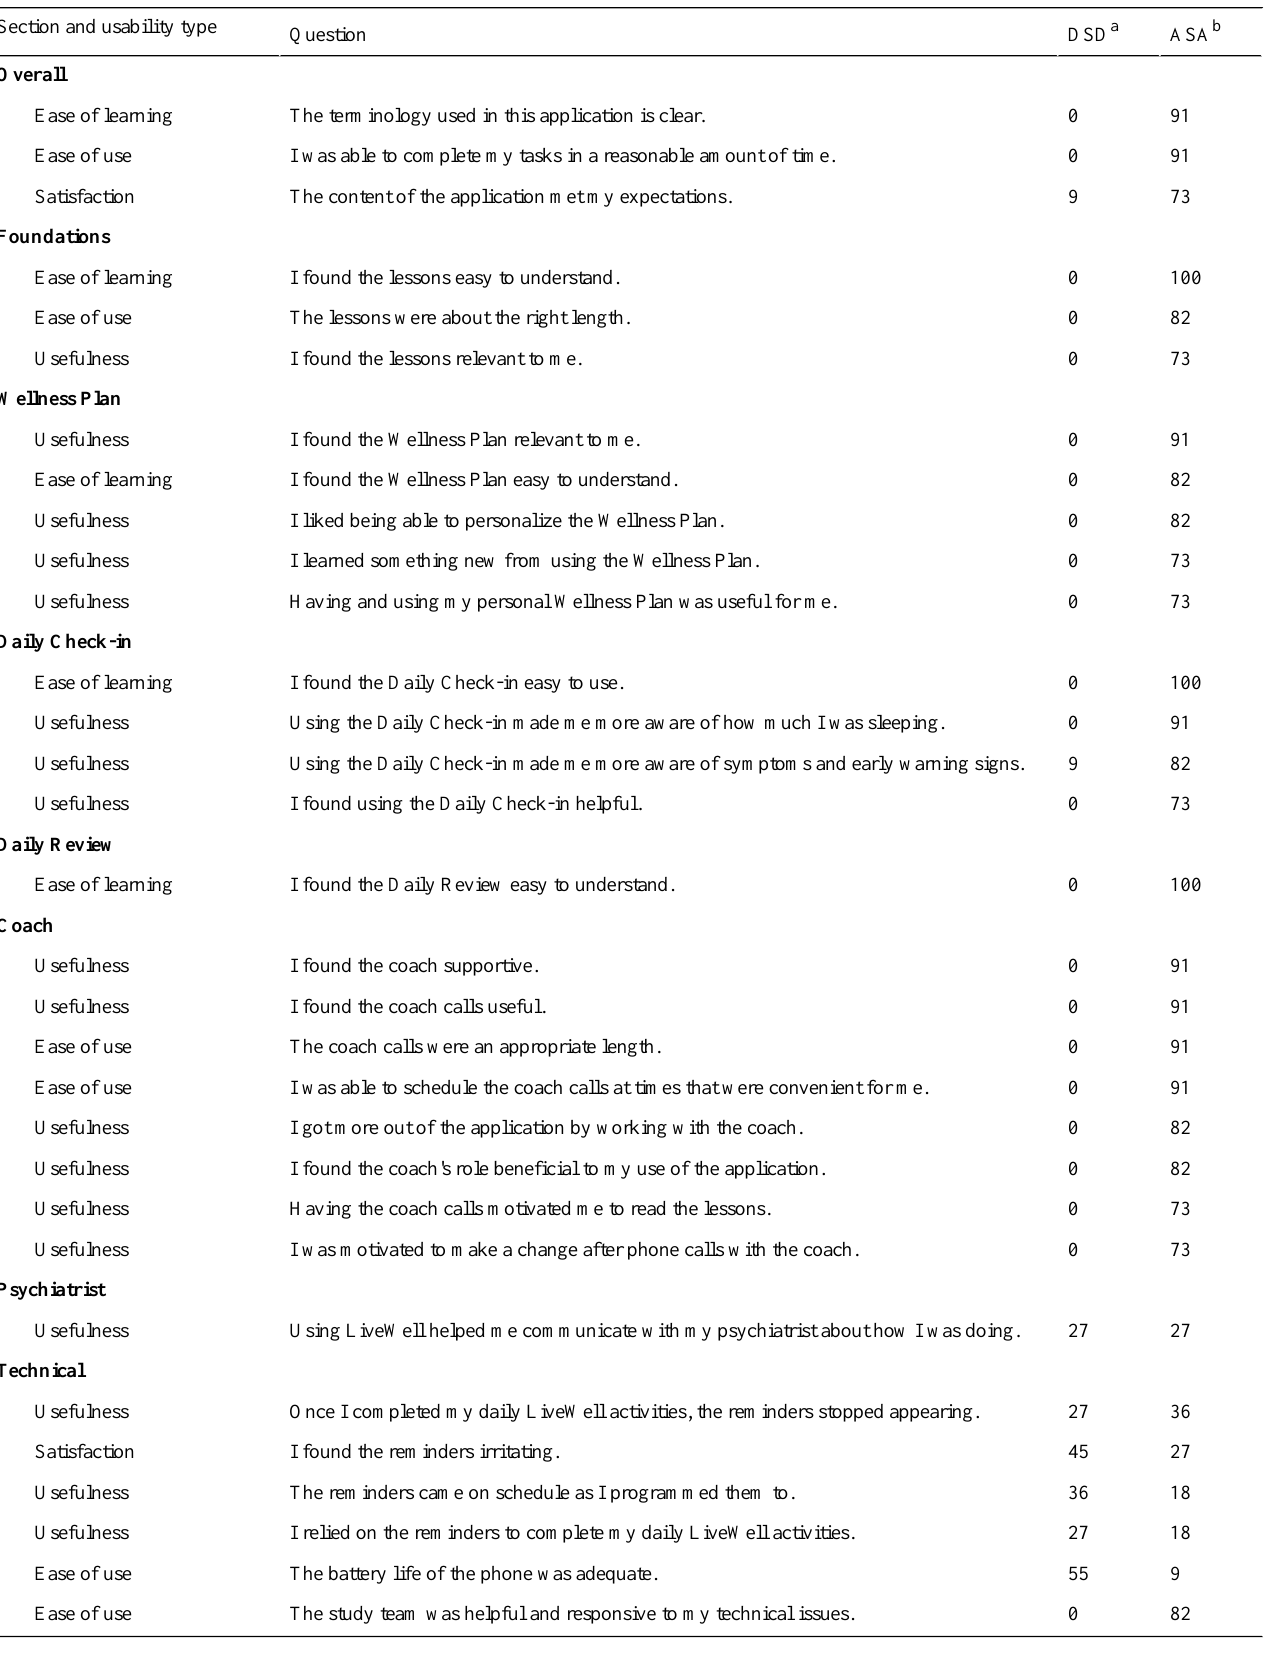
Table 6. Pilot study: usability questionnaire